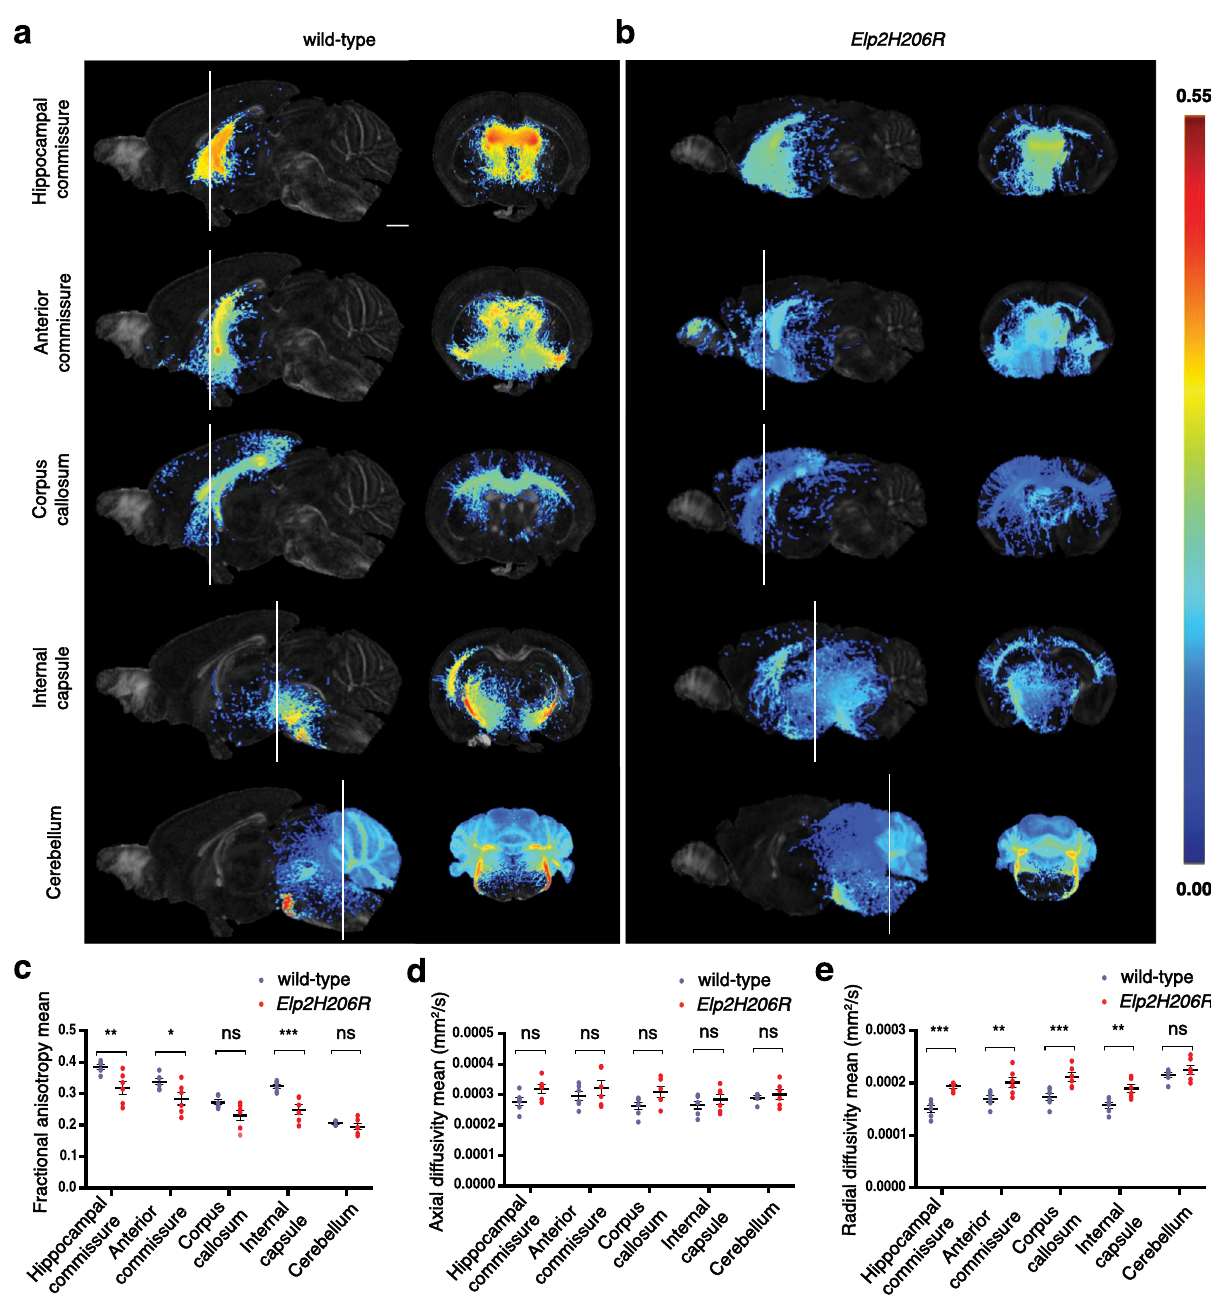
Fig. 5 Loss of axonal tract integrity among major cortical white matter structures in the brain of Elp2H206R mice. a Representative images of fractional anisotropy maps (measure of microstructural integrity of white matter axonal bundle) of the indicated brain structures in 21 – 23-days-old wild-type and b Elp2H206R homozygous mice shown in the mid-sagittal (left panel) and coronal plane (right panel). Scale bar, 1 mm. The fractional anisotropy maps are visualized at threshold from 0 to 0.55 (color scale shown on right). c Fractional anisotropy, d axial diffusivity (water diffusion parallel to axon bundle), and e radial diffusivity (water diffusion perpendicular to axon bundle) are quanti fi ed for both genotypes. n = 6 animals per genotype. Statistical analysis: unpaired two-tailed t -test ( α = 0.05) with Welch ’ s correction. Holm-Sidak correction was applied to adjust for multiple comparisons. Statistically signi fi cant differences are indicated (* p ≤ 0.05; ** p ≤ 0.01; *** p ≤ 0.001; ns - not signi fi cant: for ( c ) p = 0.0689 for corpus callosum and p = 0.6554 for cerebellum; for ( d ) p = 0.2211 for hippocampal commissure, p = 0.627 for anterior commissure, p = 0.1969 for corpus callosum, p = 0.6349 for internal capsule and p = 0.6349 for cerebellum; for ( e ) p = 0.3235). Data represent mean ± SEM. Source data are provided as a Source Data fi